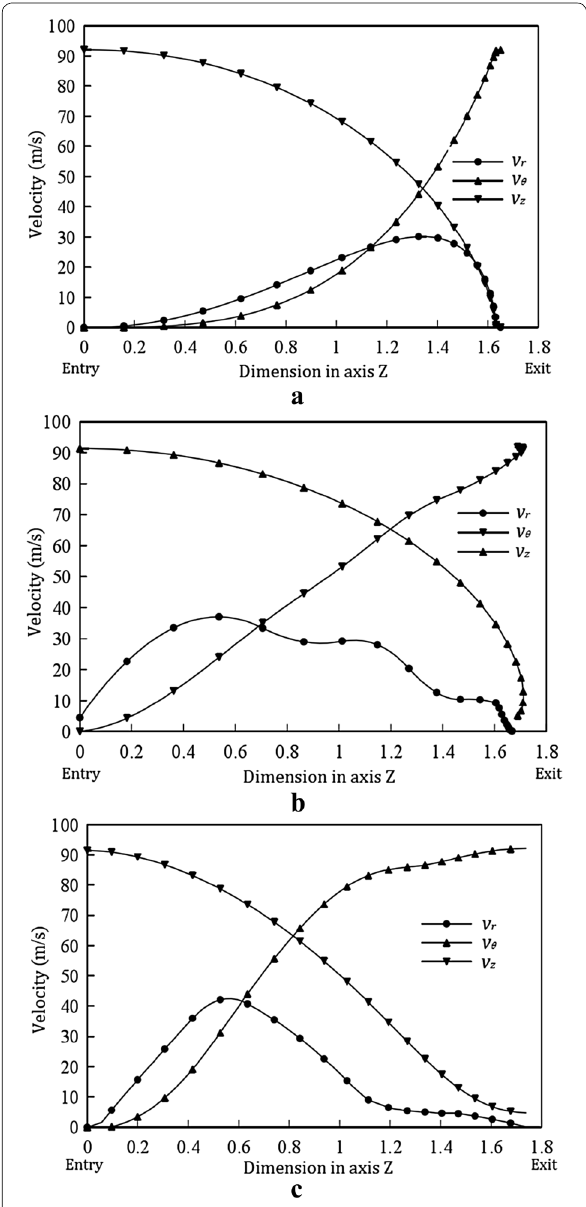
Figure 15 Numerical results for wire rod relative velocity in different laying pipes: a relative velocity in laying pipe curve δ 1 ; b relative velocity in laying pipe curve δ 2 ; c relative velocity in laying pipe curve